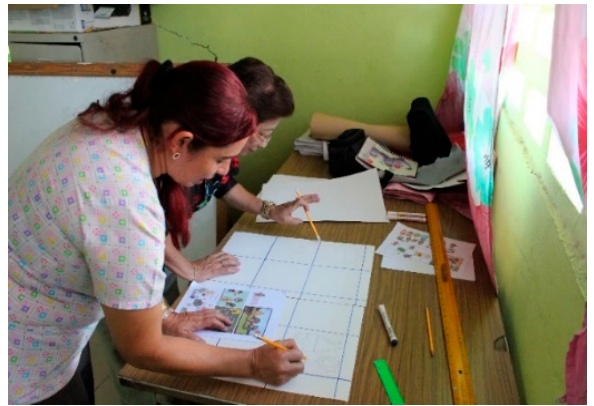
Figure 3. Practical workshop for making